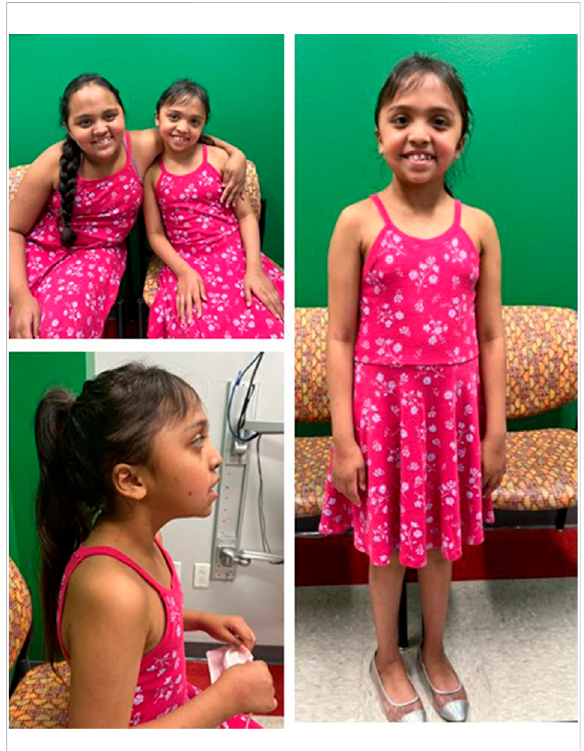
FIGURE 2 Patients 1 and 2 at ages 9 and 8 years, respectively demonstrate similar facial features (A). Pro fi le (B) and full (C) views of patient 2 at age 8 demonstrating almond-shaped eyes,